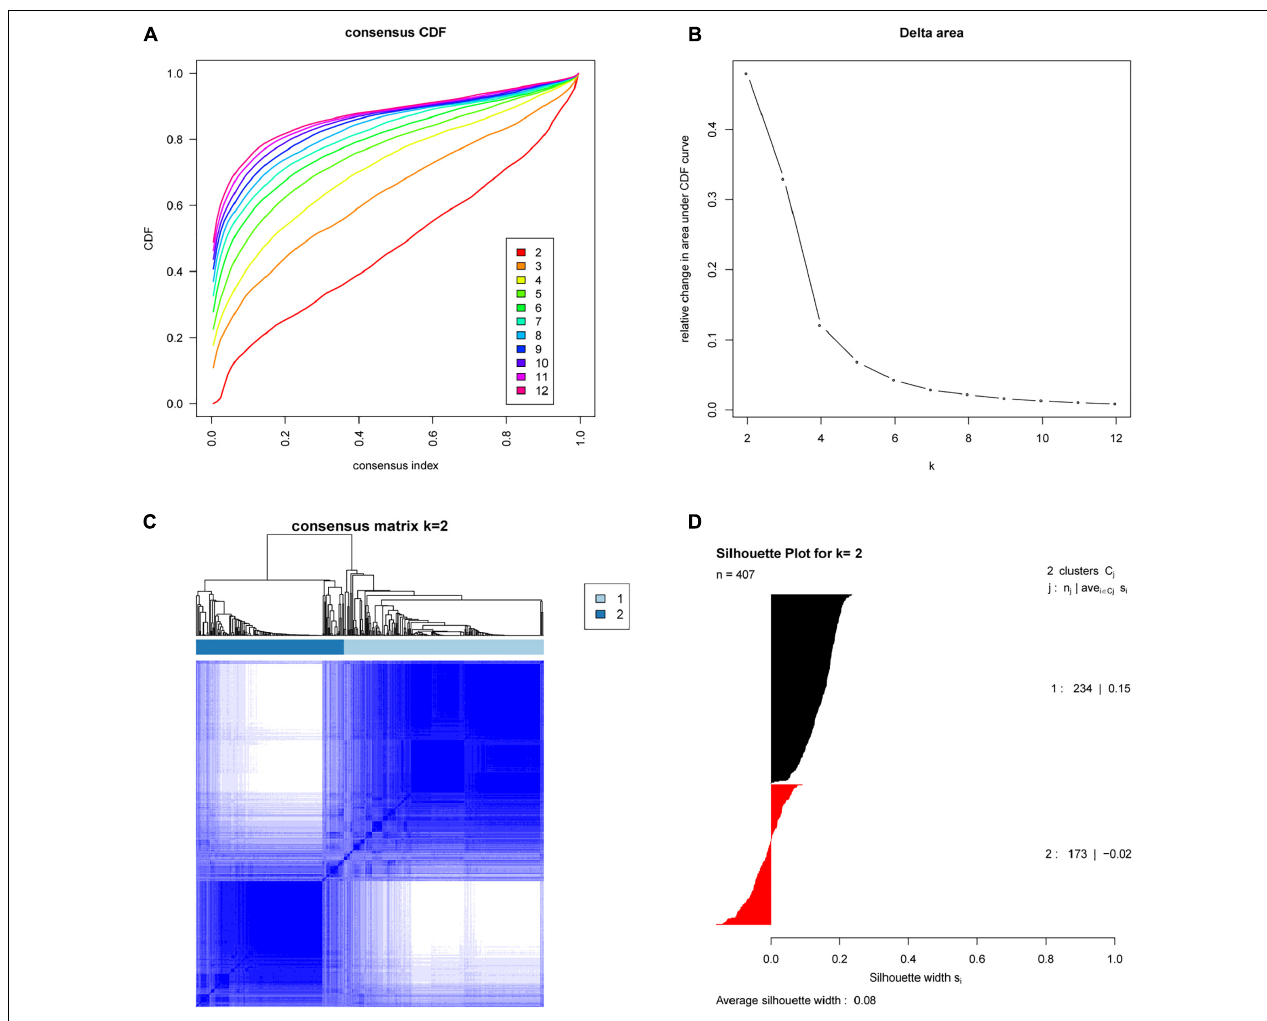
FIGURE 1 | Identification of two molecular subtypes of EAC in the TCGA cohort (Discovery cohort). (A) Empirical cumulative distribution plot determines the optimal number of EAC molecular subtypes. (B) Relative increase in the area under the CDF curve along with increasing assumed number of molecular subtypes. (C) Consensus Clustering matrix shows two molecular subtypes of EAC in TCGA. (D) Silhouette analysis of TCGA cohort using assignments from Consensus Clustering.